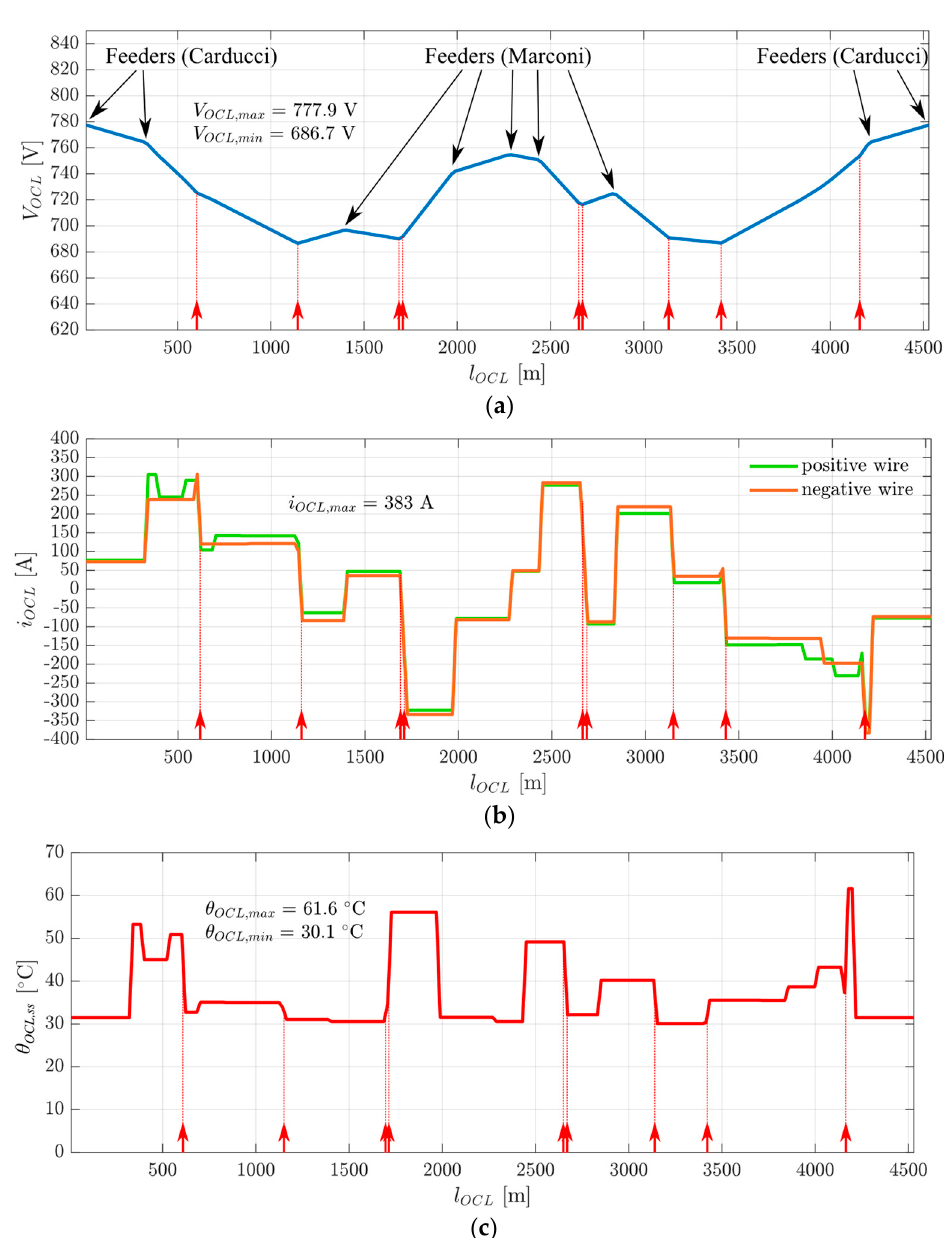
Figure 11. Distributions of OCL voltage ( a ), pole currents ( b ), and steady state temperature ( c ) along FS 2. Trolleybus positions are marked by red arrows.